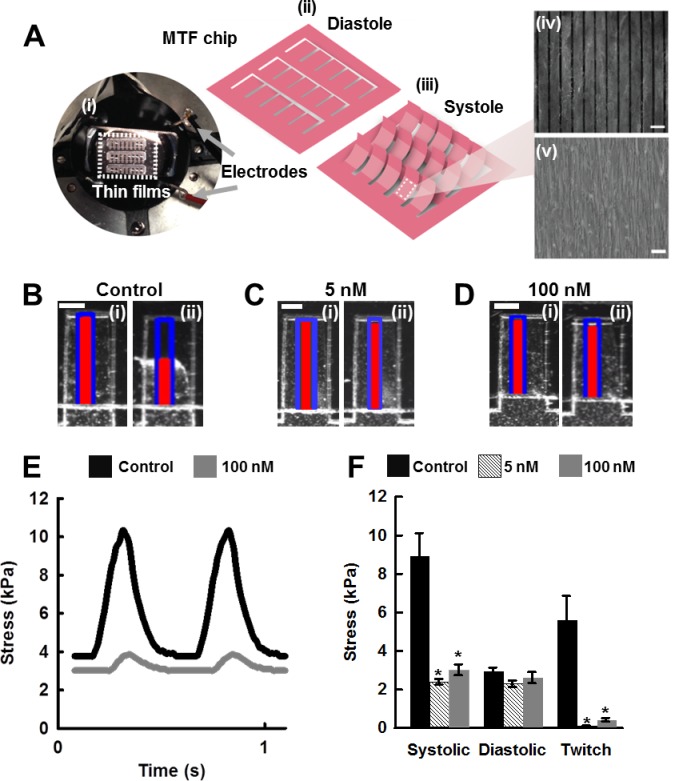
ANG II treatment leads to decreased contractile function.(A,) MTF Chip. (A,i) Photograph of experimental setup (Scale bar: 1 cm). (A ii-iii) Schematic of the MTF chip in diastole (ii) and systole positions (iii). Microcontact printing was used to pattern cells to resemble the structure of heart tissue architecture mimicked on the MTF chip (Scale bar: 20 μm). (A,iv) Fibronectin patterns on surface of thin film drive tissue architecture (Scale bar: 20 μm). (A,v) Brightfield image of engineered cardiac tissues on the MTF. (B-D) (i) Diastole and (ii) peak systole of muscular thin films. Blue outline represents the original film length, red line represents the x-projection of the radius of curvature of the film (Scale bar: 500 μm). (E) Representative stress traces generated from x-projections of films (F) ANG II treatment leads to a decrease in contractile stress generation. Control n = 85 tissues, 5 nM n = 15 tissues, 100 nM n = 69 tissues, 3 harvests. Tissues were paced at 2Hz (mean ± SEM, * indicates p < 0.05 vs control, # indicates p < 0.05 vs. 100 nM).